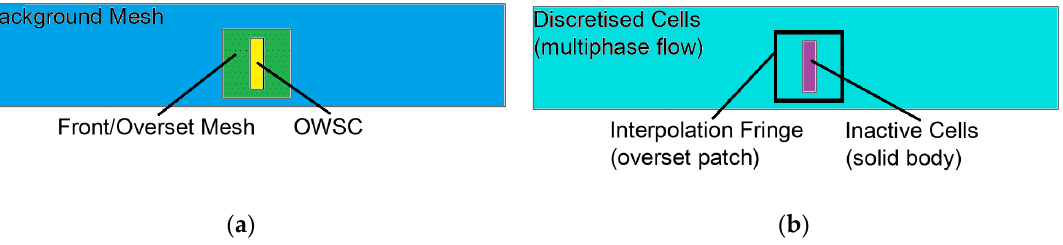
Figure 2. ( a ) Overlapping meshes. (1) Background mesh: Consists of the two-phase flow of the Numerical Wave Tank (NWT), (2) overset or front mesh: Consists of the surrounding mesh of the solid body, and, (3) Oscillating Wave Surge Converter (OWSC): The body is conformed using the Cartesian cell cut technique; ( b ) control volumes. (1) Discretisation cells: Discretise the governing equations of the multiphase flow, (2) interpolation cells: The solution is interpolated from mesh to mesh, and (3) inactive cells: No solution is done.